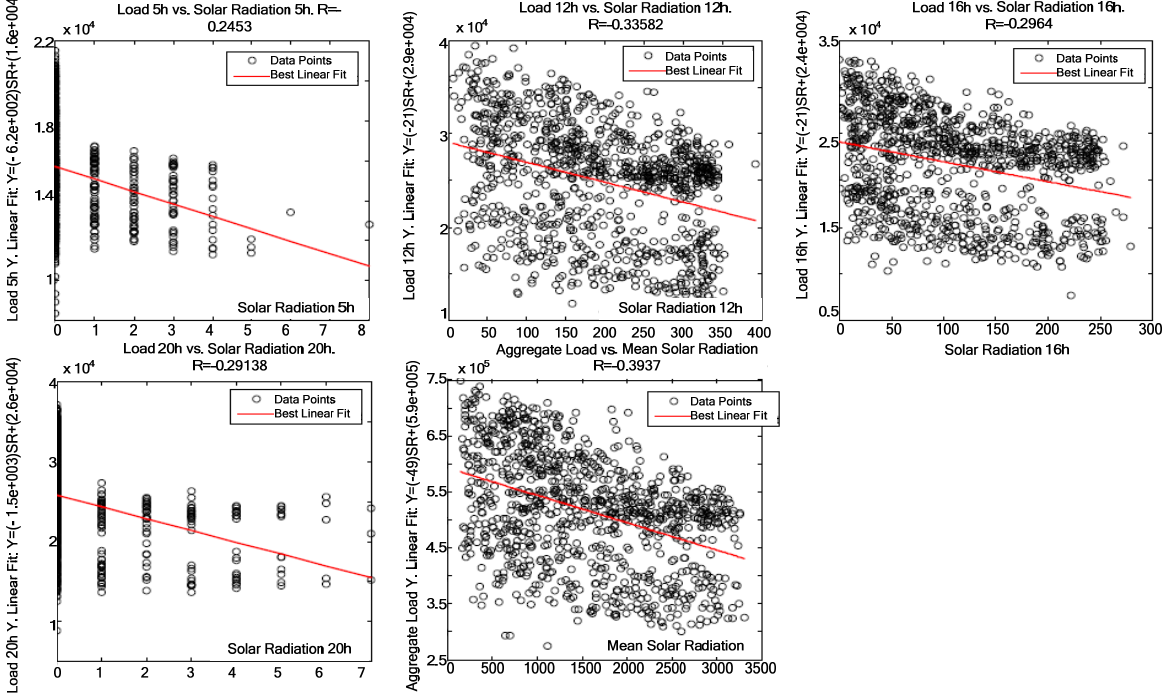
Figure 11. Correlation at 5 h, 12 h, 16 h, 20 h and average global solar radiation against electric power consumption.